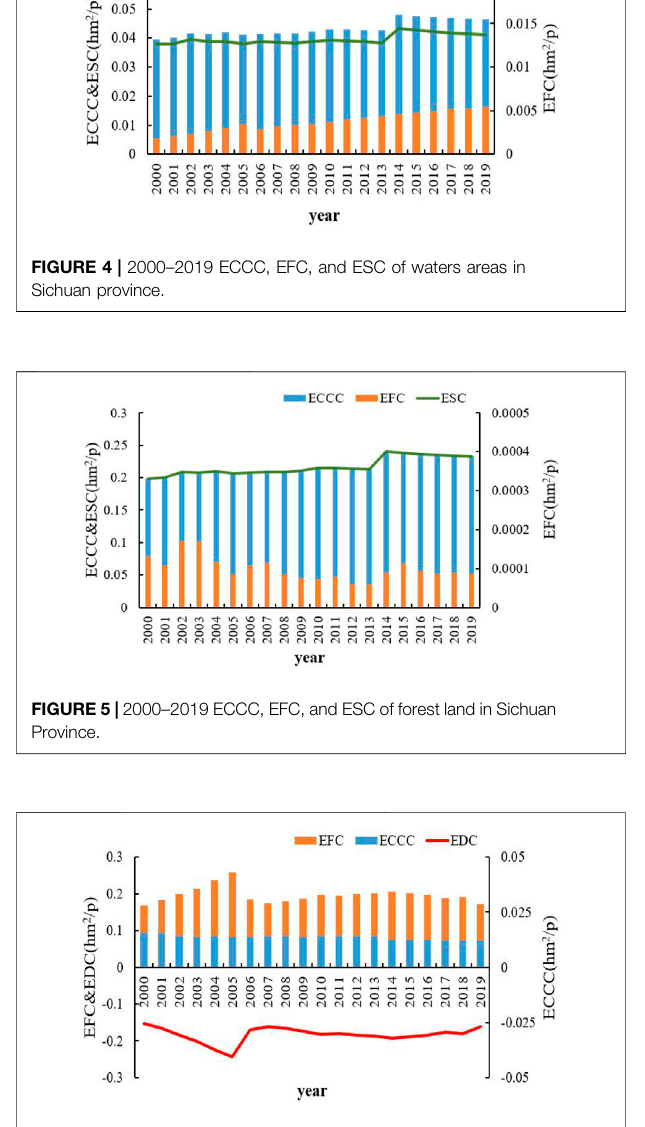
Frontiers in Environmental Science |